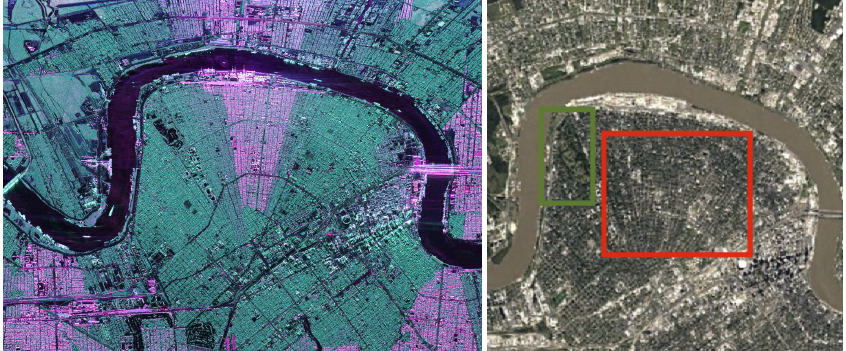
Figure 2. New Orleans, Louisiana, U.S. ( Left ) PolSAR image acquired by UAVSAR in the Pauli basis (double-bounce in red, single scattering in blue, cross-polarization in green). The sensor trajectory is parallel to the top of the figure; ( right ) Google Earth image of the same region acquired by Landsat and